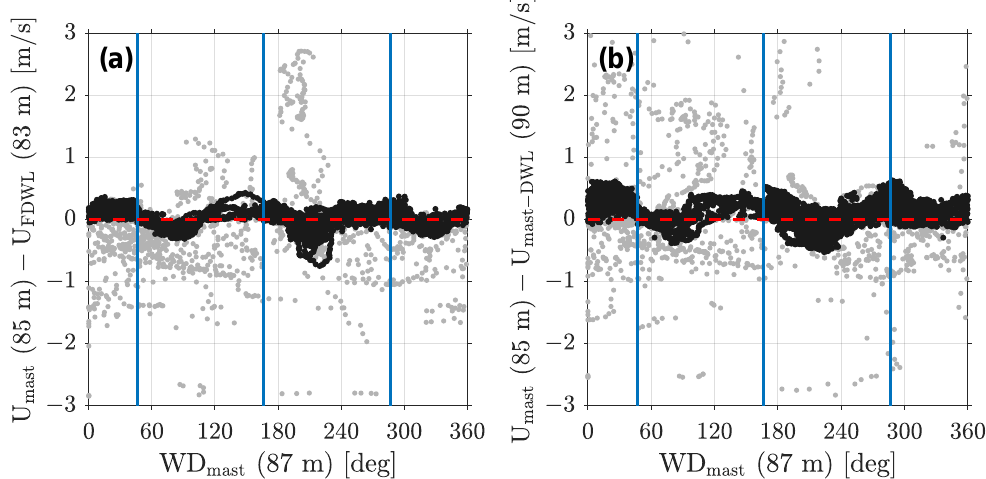
Figure 6. Anemometer data screening: WD. ( a ) HWS differences between the cup anemometer and the FDWL measurements as a function of wind direction at a 87 m height. ( b ) Same as in panel ( a ) but compared to the DWL on the mast. Vertical blue lines indicate the directions of the mast booms (46.5 ◦ , 166.5 ◦ , and 286.5 ◦ , Figure